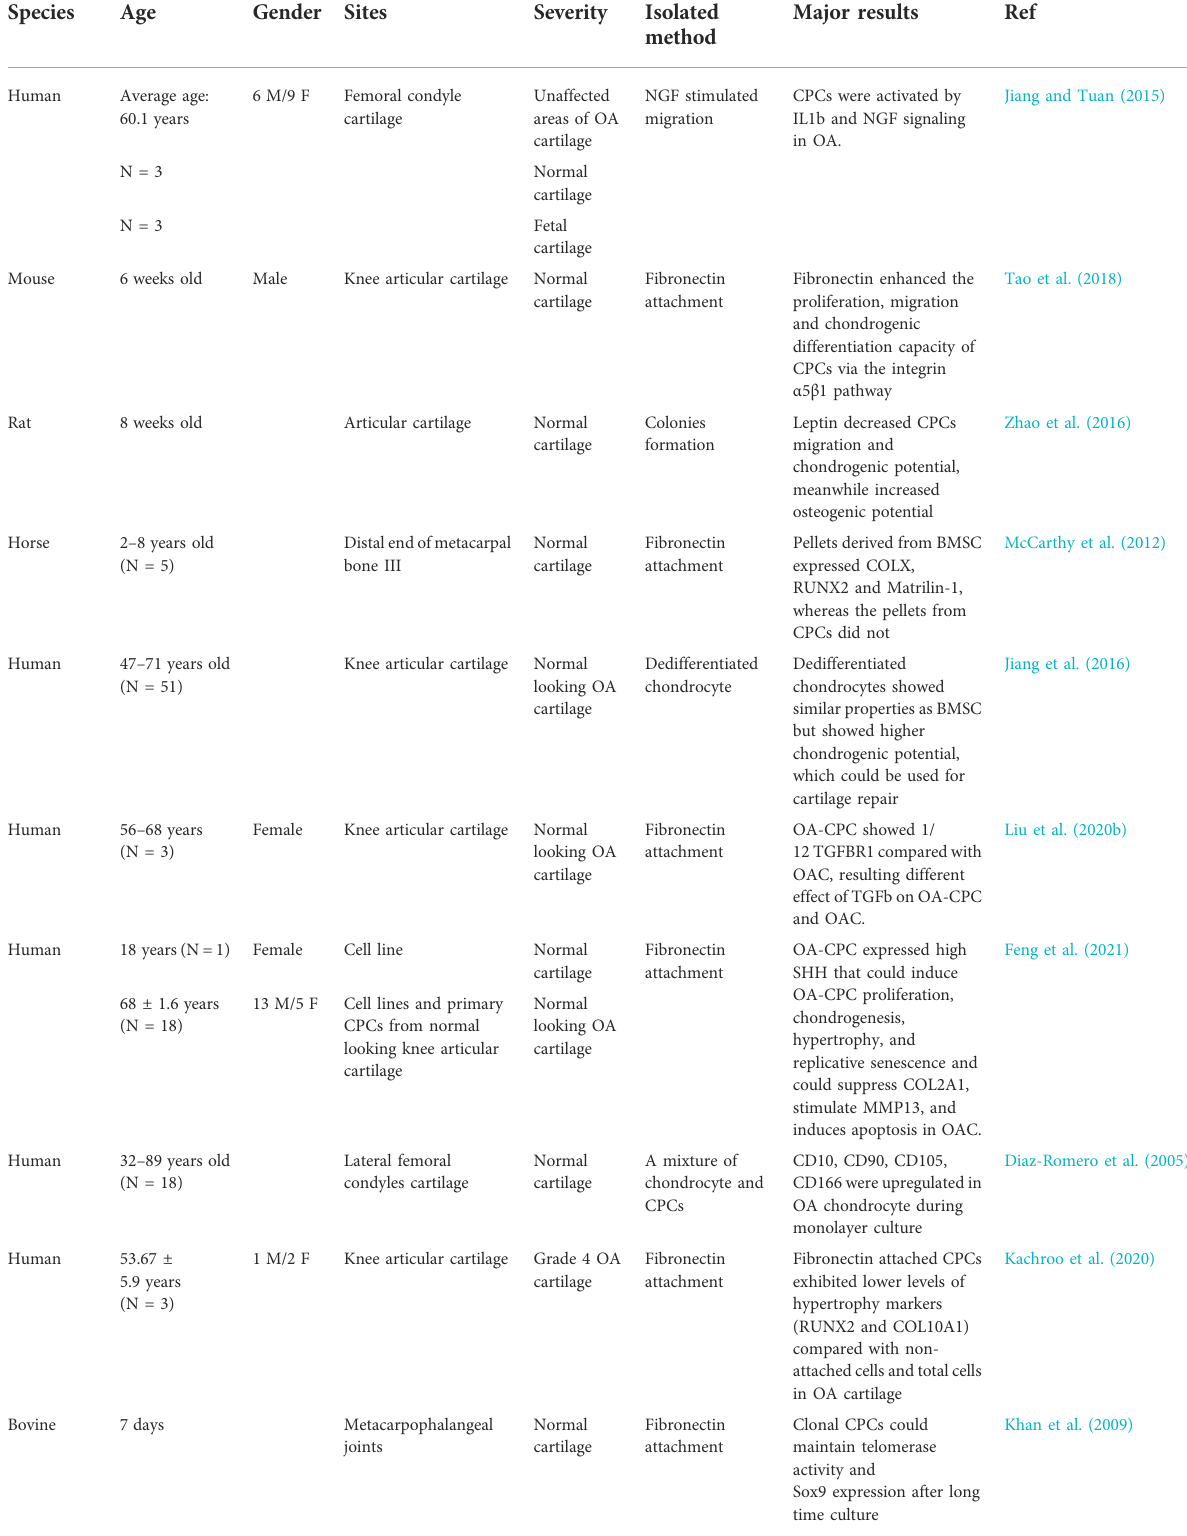
TABLE 1 The comparison of CPCs from different sources, chondrocytes and BMSCs.